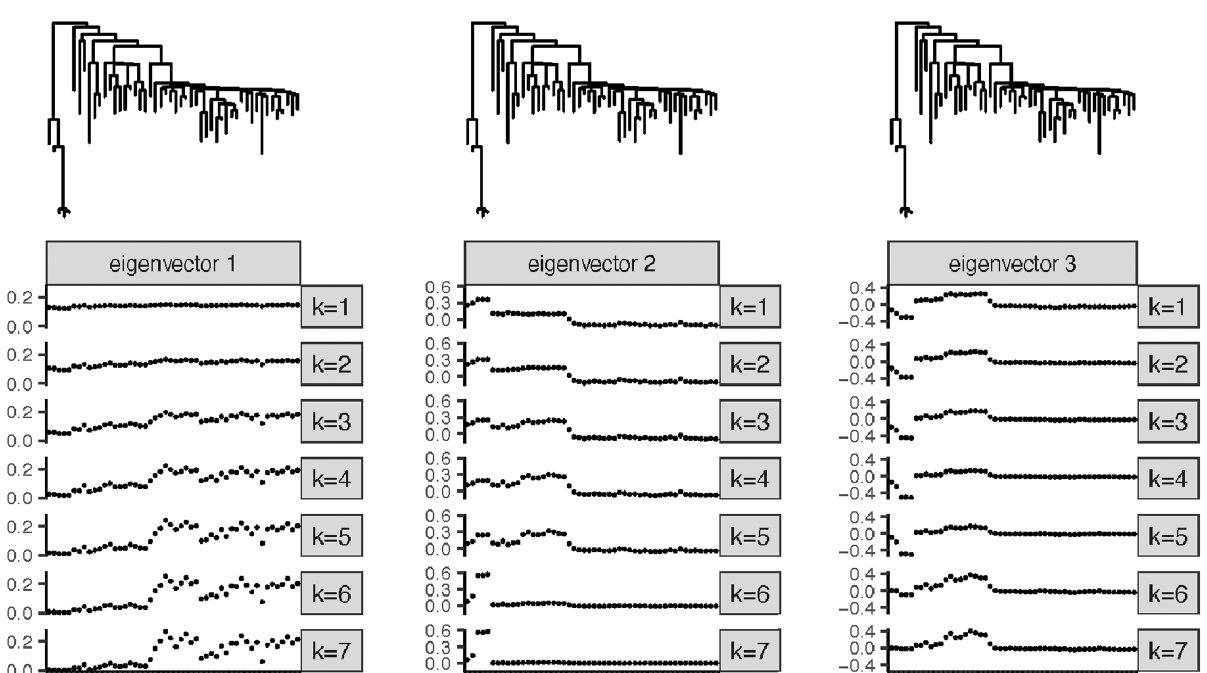
Fig 7. (Microbiome phylogeny) The first, second and third-largest eigenvector for different k values.